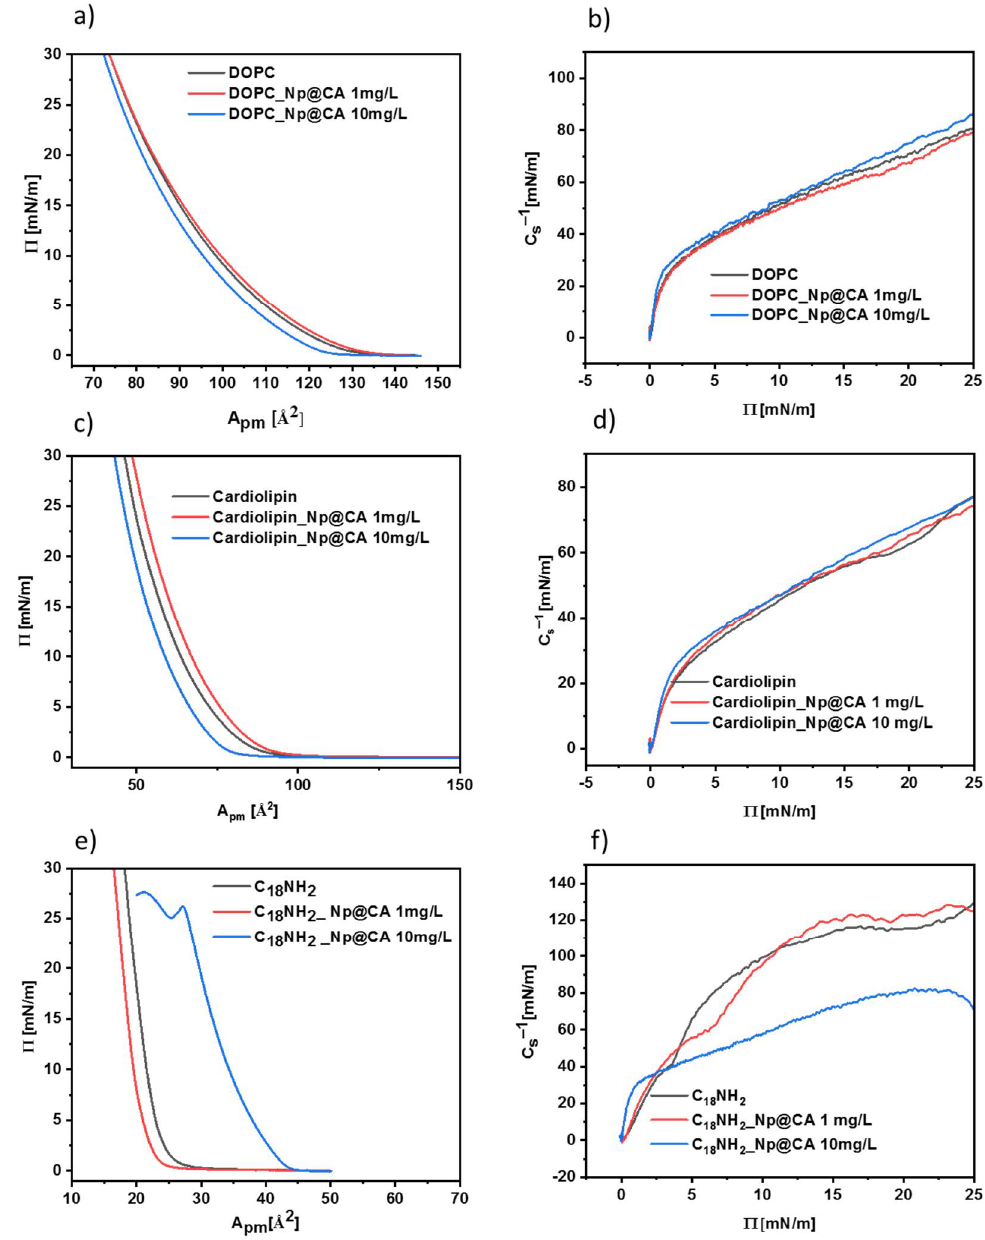
Figure 8. Langmuir isotherm and compressibility coefficient of DOPC ( a , b ), C 18 NH 2 ( c , d ), and cardiolipin ( e , f ) membranes in the presence and absence of nanoparticles (concentration of Np@CA 1 and 10 mg/L marked in the graph).